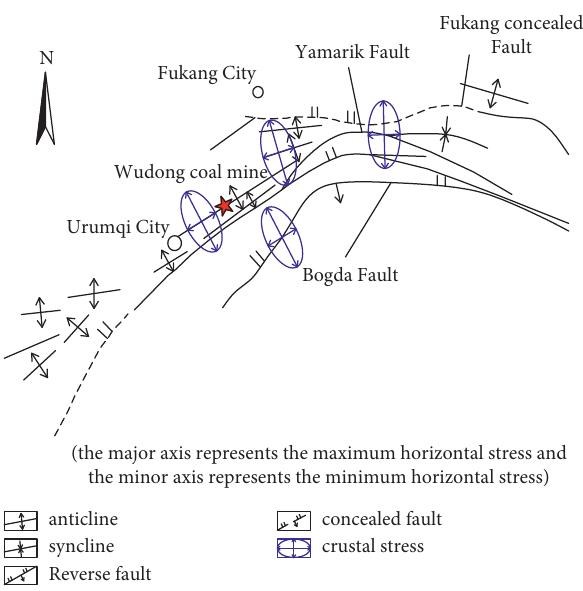
Figure 2: Structural stress distribution of the bogda fault zone